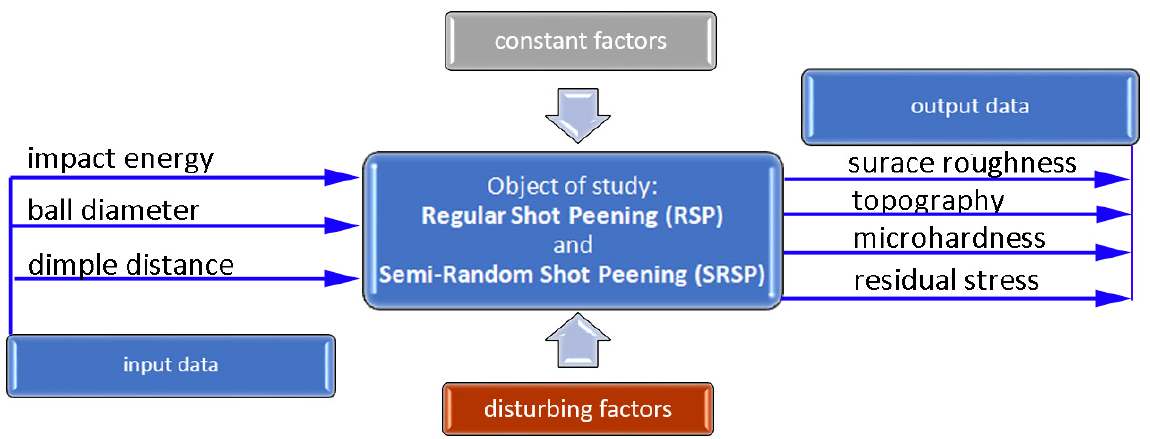
Figure 6. Diagram illustrating the methodology of the shot-peening process. Surface roughness and topography were obtained from the T8000RC120-400 profilographometer provided by Hommel–Etamic Jenooptik (Jena, Villingen-Schwenningen, Germany). Surface microhardness was analyzed with the Leco LM700 device in compliance with the EN-ISO 6507-1:2018 standard. A 50 g load was applied; the penetrator loading time was 15 s.